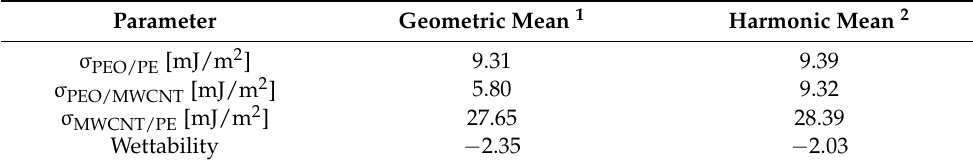
Table 1. Surface Energies and Wettability of MWCNTs within PEO and PE at 150 ◦ C.